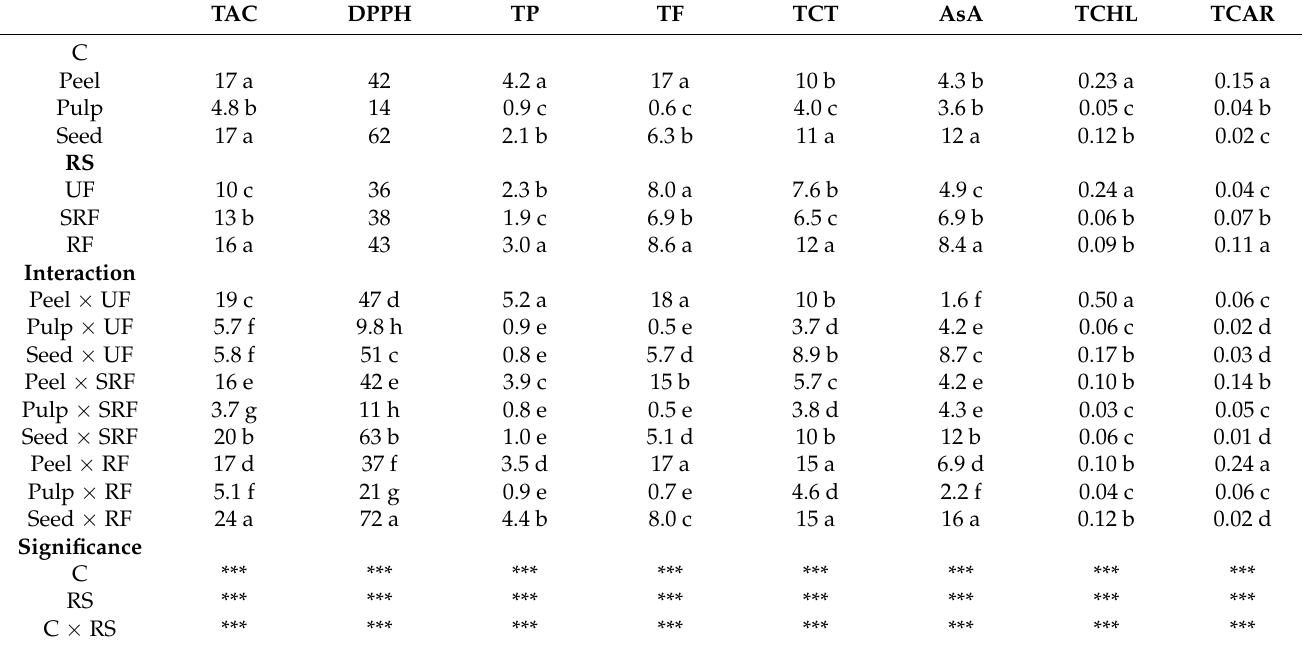
Table 3. Analysis of variance and means comparison for bioactive compounds in Phlegrean mandarin in response to different components (C) (Peel, Pulp, Seed) and ripening stage (RS) (unripe fruits—UF, semi-ripe fruits—SRF, ripe fruits—RF), as well as nine different combinations C × RS. Different letters within each column indicate significant differences according to Duncan’s multiple comparison tests ( p < 0.05). Asterisks (*) represent the level of significance for main factors (C, RS) and their interaction (C × RS): NS—not significant; *** p <